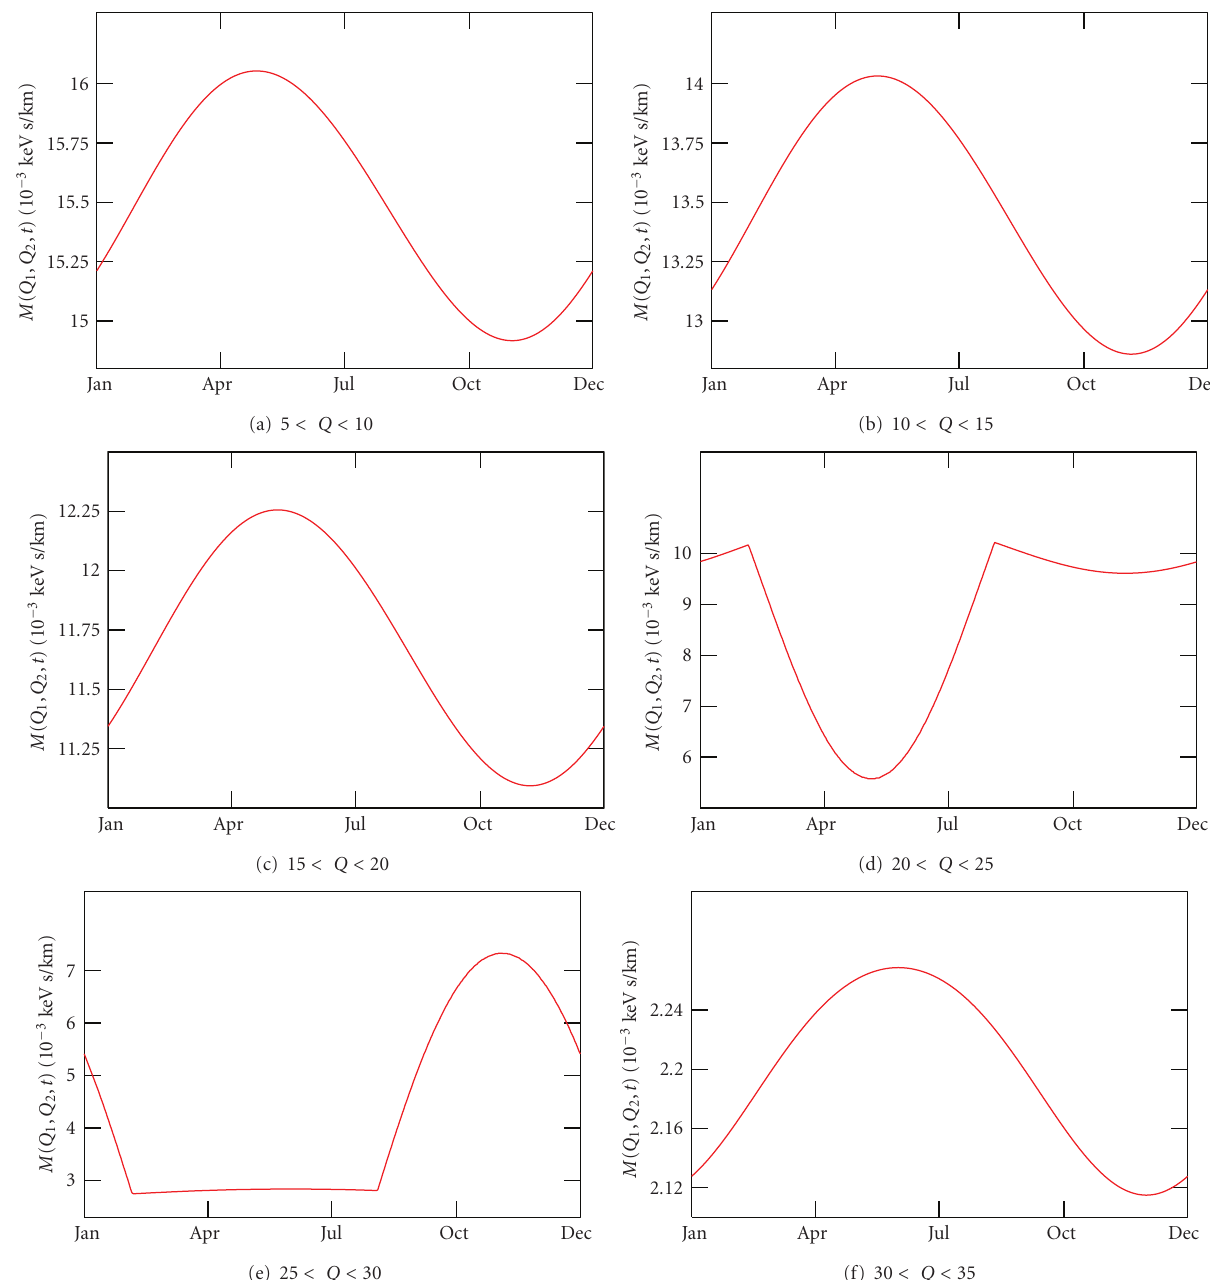
Figure 5: Annual modulation in M(Q 1 ,Q 2 ,t) for the caustic flow (a). Q is in keV. Case ξ = 0 . 5.